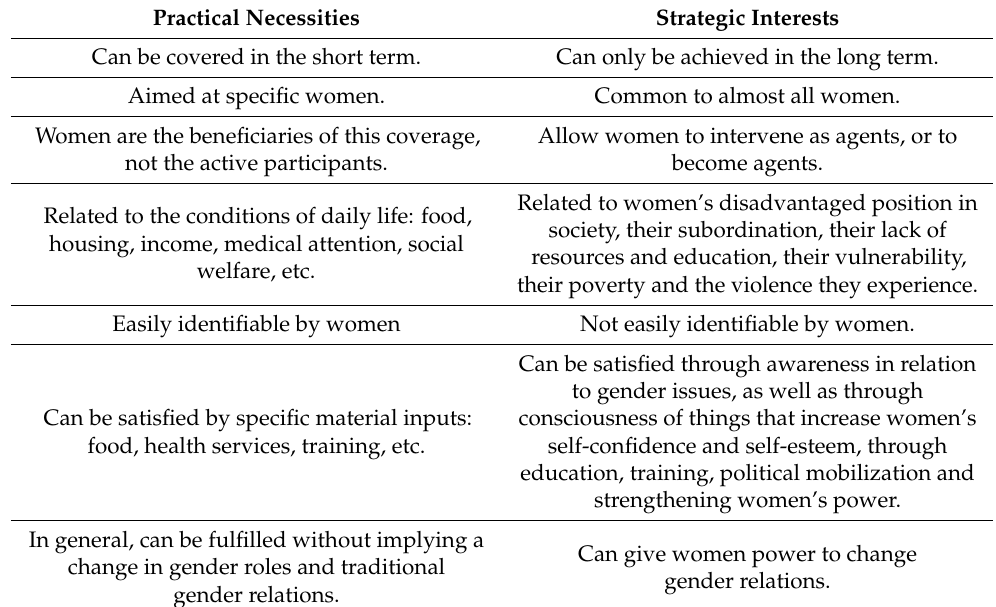
Table 6. Analytical categories to identify practical gender needs and strategic gender